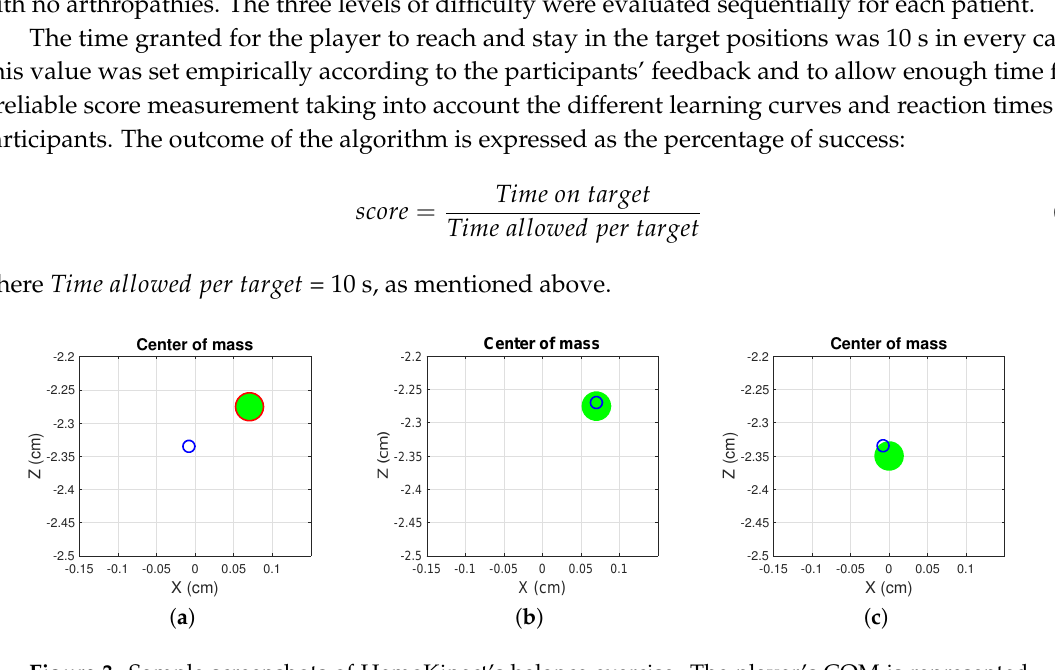
Figure 3. Sample screenshots of HemoKinect’s balance exercise. The player’s COM is represented by a blue circumference. The current target position is represented by a green circle of radius 1.5 cm, whose edge changes color from red to green when the player’s COM is inside it. The figure